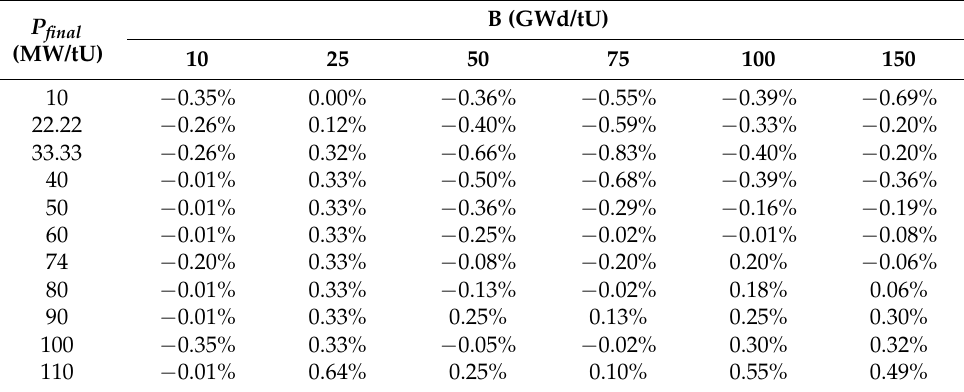
Table 4. Variance between current results from Equation (19) and those from KORIGEN. P final